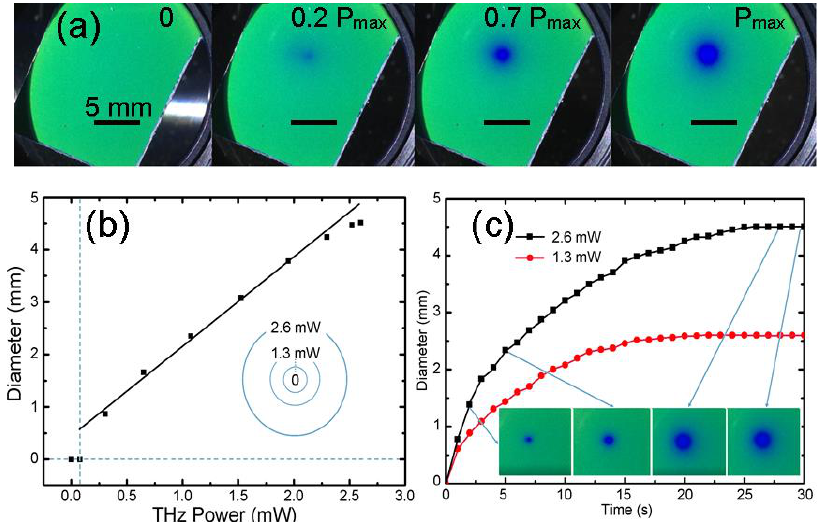
Figure 4. ( a ) Visible pictures are taken under different THz intensities by a smartphone camera with Bluetooth. ( b ) Increase in the diameter of the color change with different THz powers in thermal equilibrium, similar to the target shown in the inset. ( c ) Increase in the diameters as a function of response time with 1.3 and 2.6-mW THz radiation. The inset shows image changes under different THz radiation times.